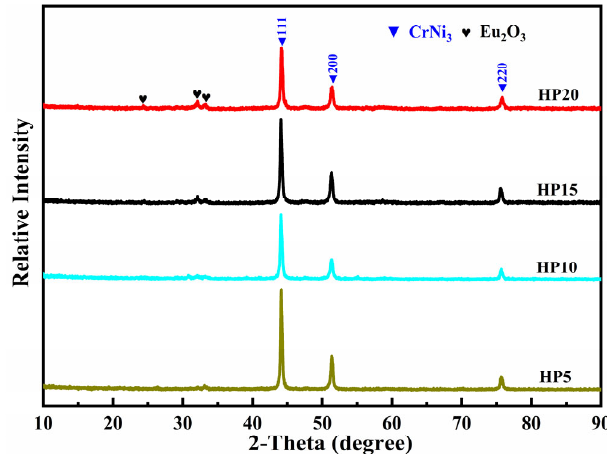
Materials 2023 , 16 , 1473